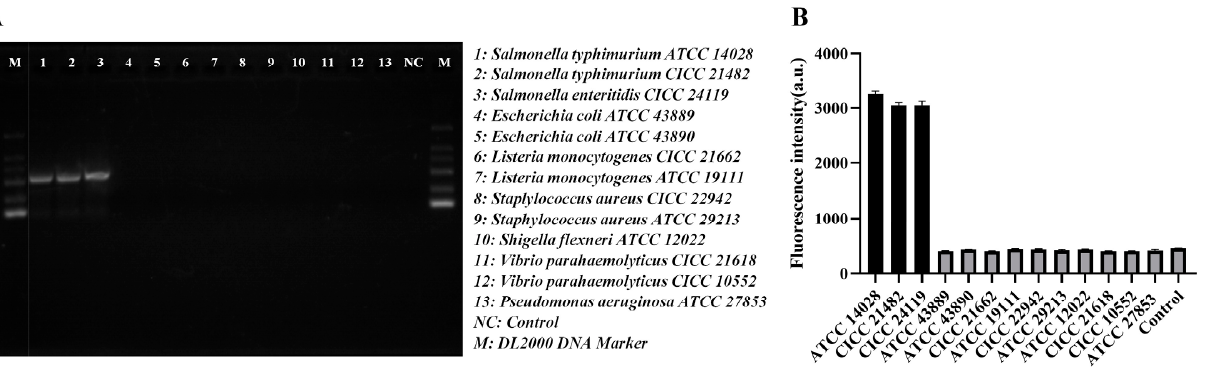
Figure 6. The gel electrophoresis ( A ) and absorption intensity ( B ) of the UCNPs-MB PCR biosensor with the addition of different bacterial DNA PCR products.